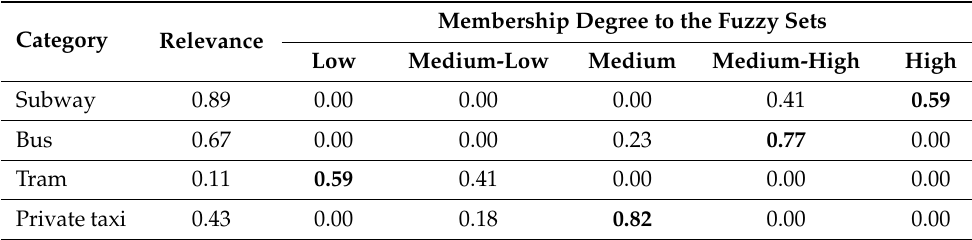
Table 1. Example of classification of documents: relevance of the categories in a document.